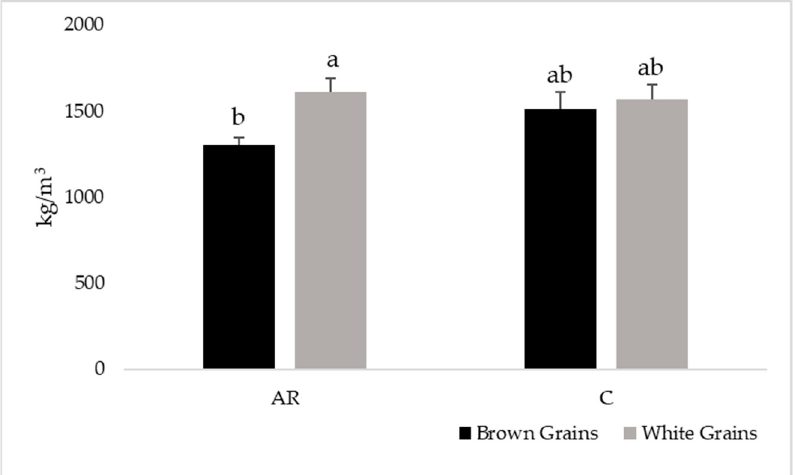
Figure 2. Average (kg/m 3 ) ± standard deviation ( n = 4) density of brown and white rice grains of Oryza sativa L. varieties Ariete (AR) and Ceres (C) at harvesting. Letters a and b indicate significant differences among grains in each variety ( p ≤ 0.05).